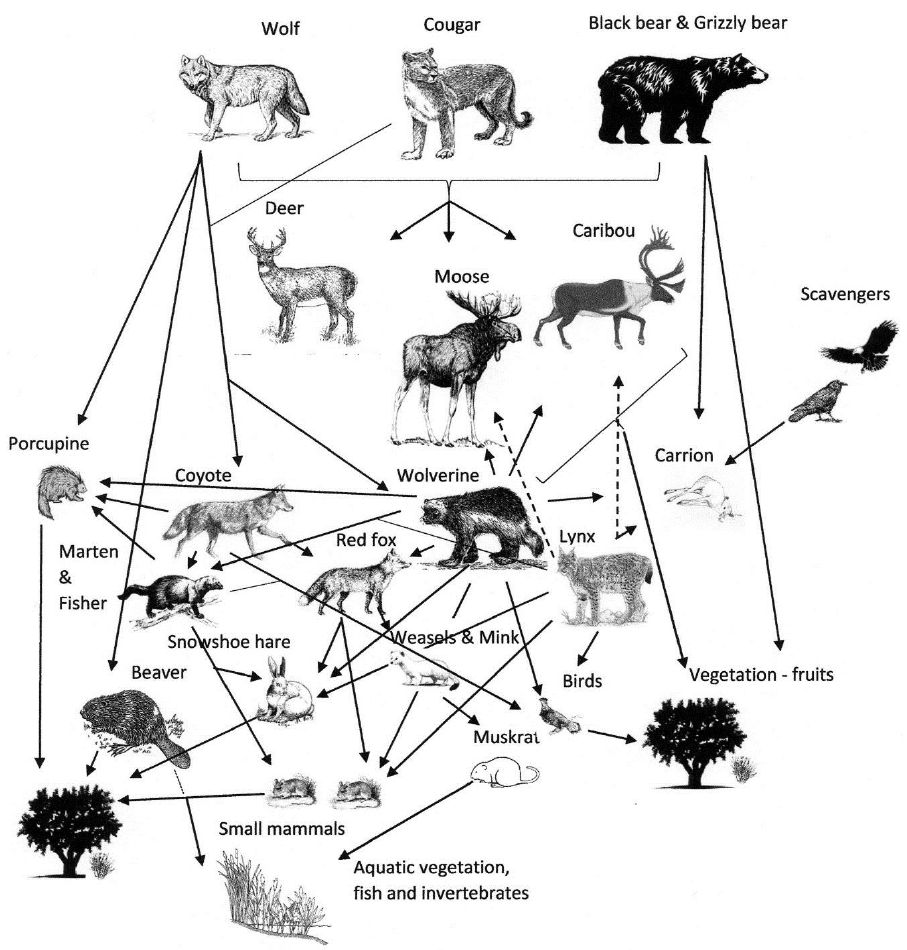
Figure 1. Conceptual diagram of a relatively complex food web in the Little Smoky caribou